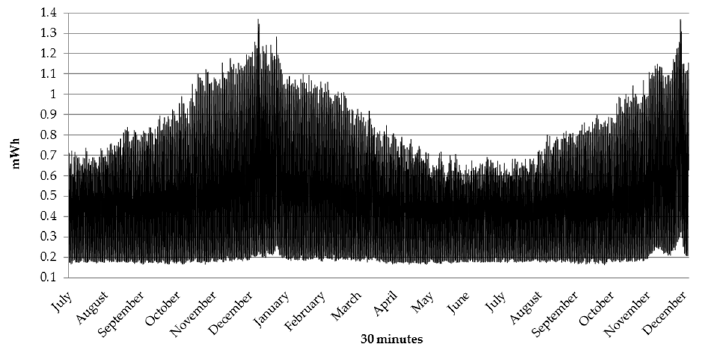
Figure 3. Thirty minutes of load data for 1000 customers recorded between 15 July 2009 and 31 December 2010 .